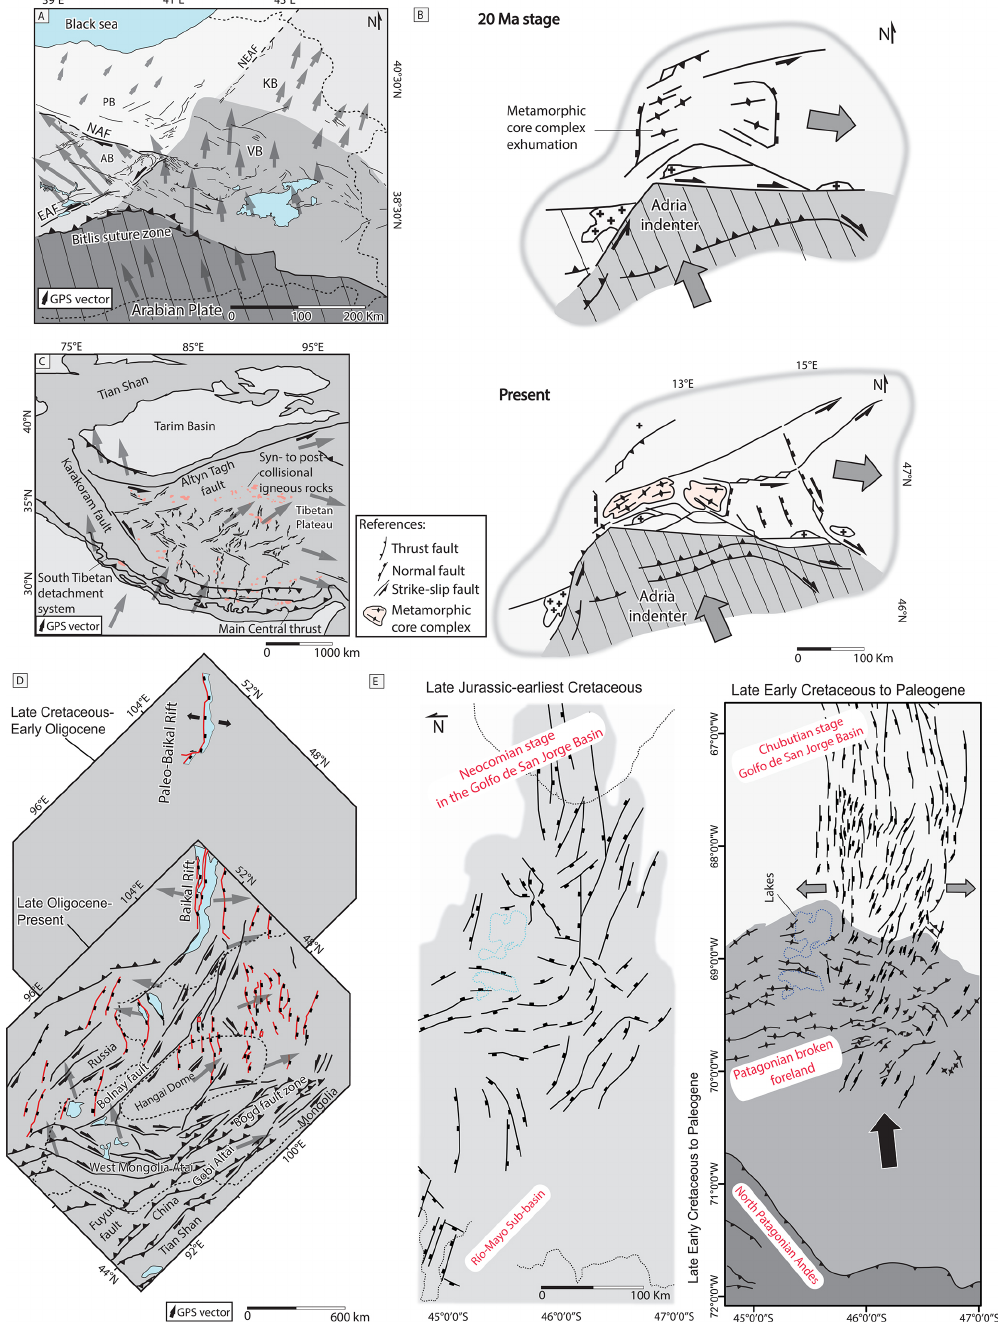
Figure 12. (a) Structural map of the eastern Anatolia region with GPS vector indicating crustal blocks kinematics. AB: Anatolide Block; KB: Kars Block; PB: Pontide Block; VB: Van Block; EAF: East Anatolian Fault; NAF: North Anatolian Fault; NEAF: North-East Anatolian Fault. Map modified from Hisarlıet al. (2016). (b) Indentation and lateral extrusion in the Alps. At 20Ma: onset of indentation, folding, and rapid extensional exhumation of thickening orogenic crust; fragmentation of wedge-shaped Austro-alpine units south of the Tauern Window (basement complex). At present day: oblique thrusting in southern Alps, dextral strike-slip in northern Dinarides, and eastward lateral crustal extrusion. Map modified from Scharf et al. (2013). (c) Structural sketch map of the Tibetan Plateau modified from Lu et al. (2018). (d) Latest Cretaceous–early Oligocene reconstruction of the paleo-Baikal lake rift from Mats and Perepelova (2011) and a map of active structures in the Central Asia region from Yin (2010). (e) Jurassic–Early Cretaceous extension and subsequent synorogenic foreland rifting reactivation stage of the late Early Cretaceous–Paleogene San Jorge Gulf basin in Patagonia. Map modified from Gianni et al. (2015).